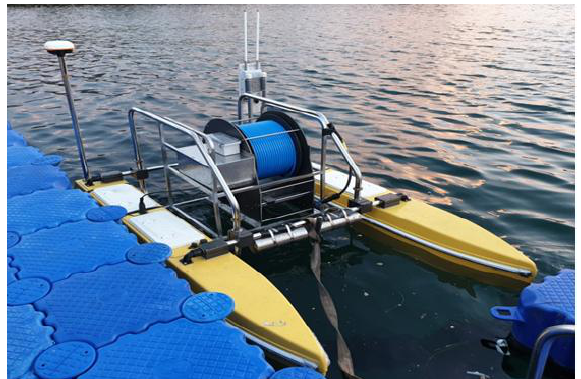
Figure 1. System structure of the unmanned surface vehicle (USV) system.